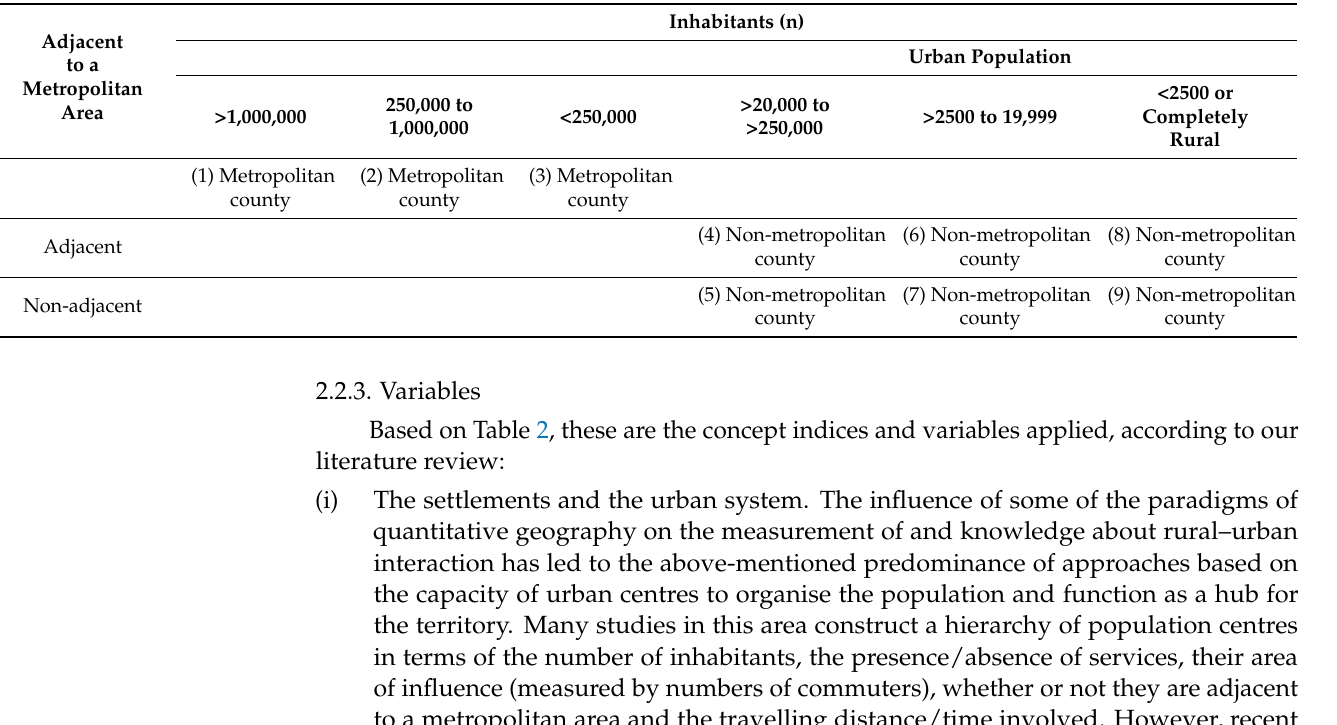
Table 3. Classification of counties according to the Rural-Urban Continuum Codes of the US Depart- ment of Agriculture. Criteria applied and values